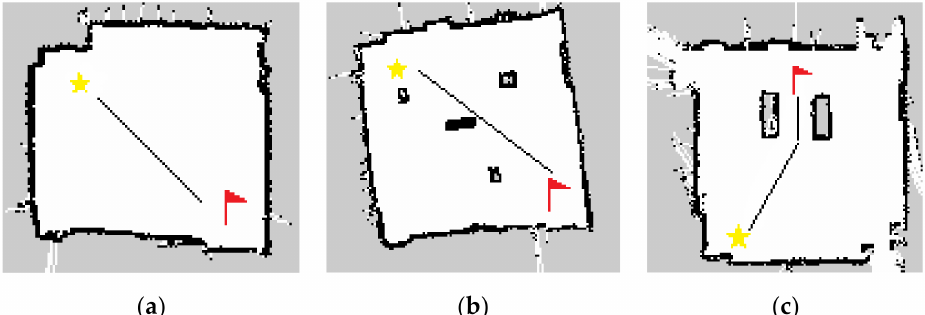
Figure 20. Experimental maps: ( a ) obstacle-free scene; ( b ) random obstacle scene; ( c ) narrow passage.